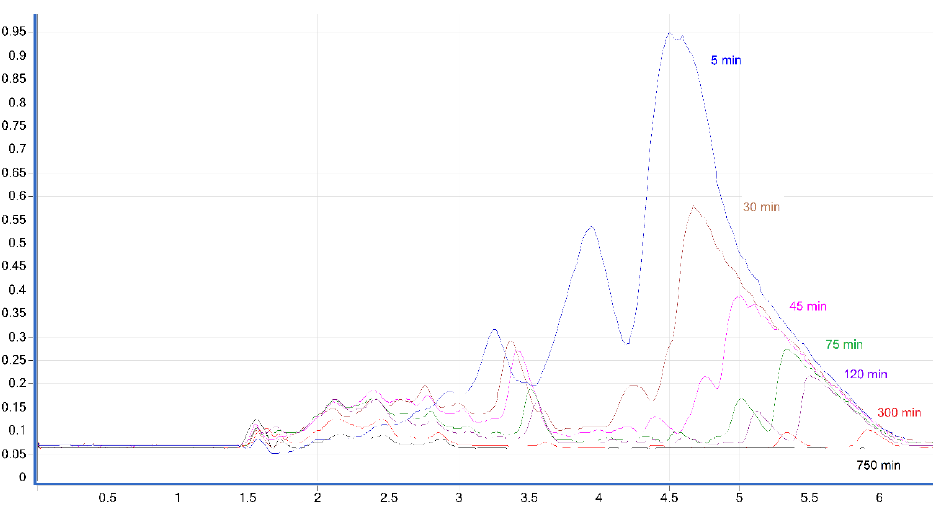
Fig. 10. HPLC-MS/MS analysis of DY-12 dye degradation using AOP at different time interval (5, 30, 45, 75, 120, 300 and 750